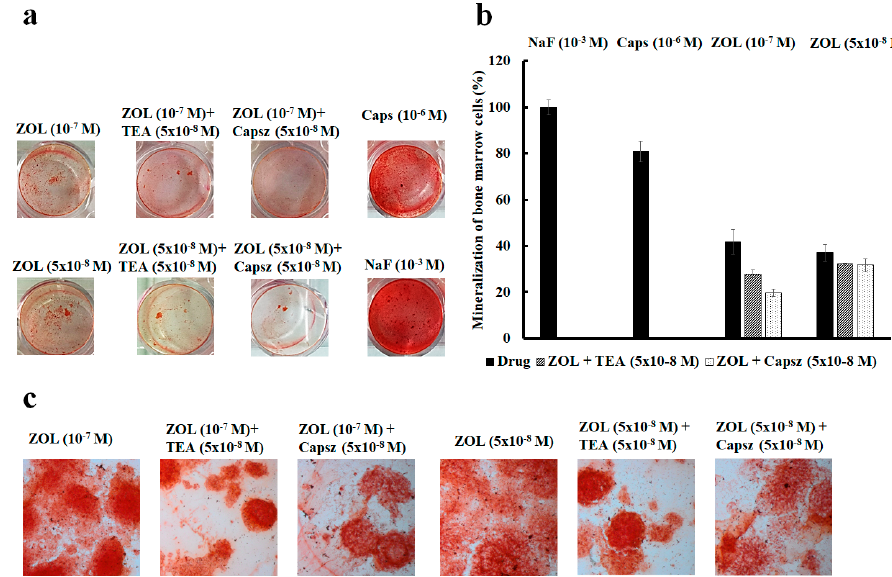
Figure 8. ( a ) Mineralization assay with alizarin red S staining for calcium nodules upon treatment with different ion channel modulators in the presence or absence of ZOL after 15 days of incubation in murine bone marrow cells. ( b ) ZOL-induced mineralization respect to NaF (10 − 3 M). ZOL capability to mineralize is reduced by co-application with capsazepine and TEA. ( c ) Alizarin red S staining for calcium nodules after 21 days of incubation in MC3T3-E1 cells after treatments with different ion channel modulators in the presence or absence of ZOL. Images were captured using an Olympus CX41 biological system microscope at 40× magnification.